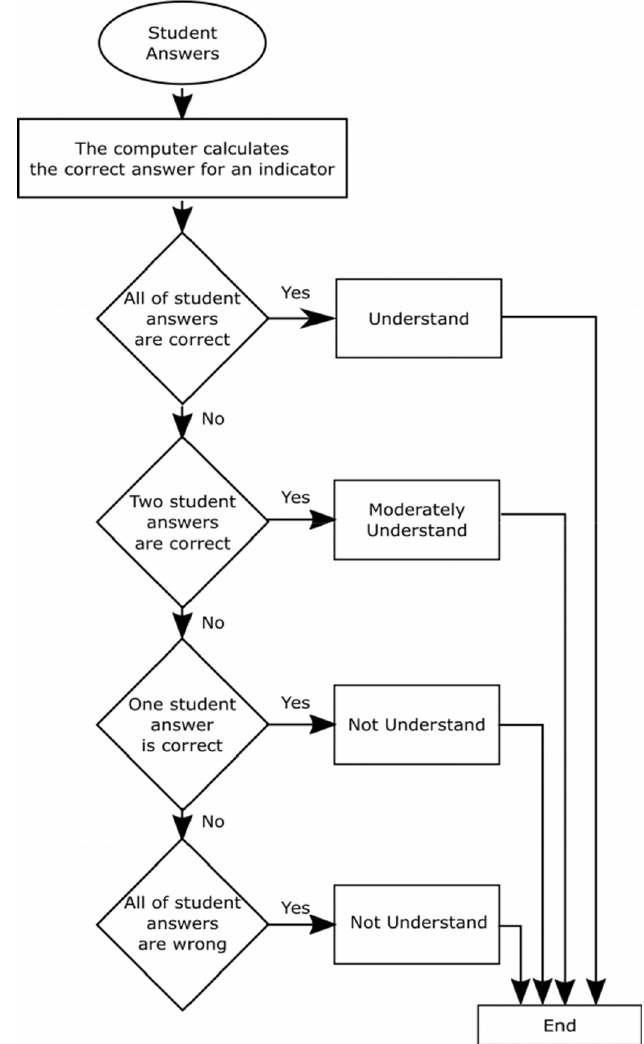
Figure 3. Flow Chart Mechanism of Producing